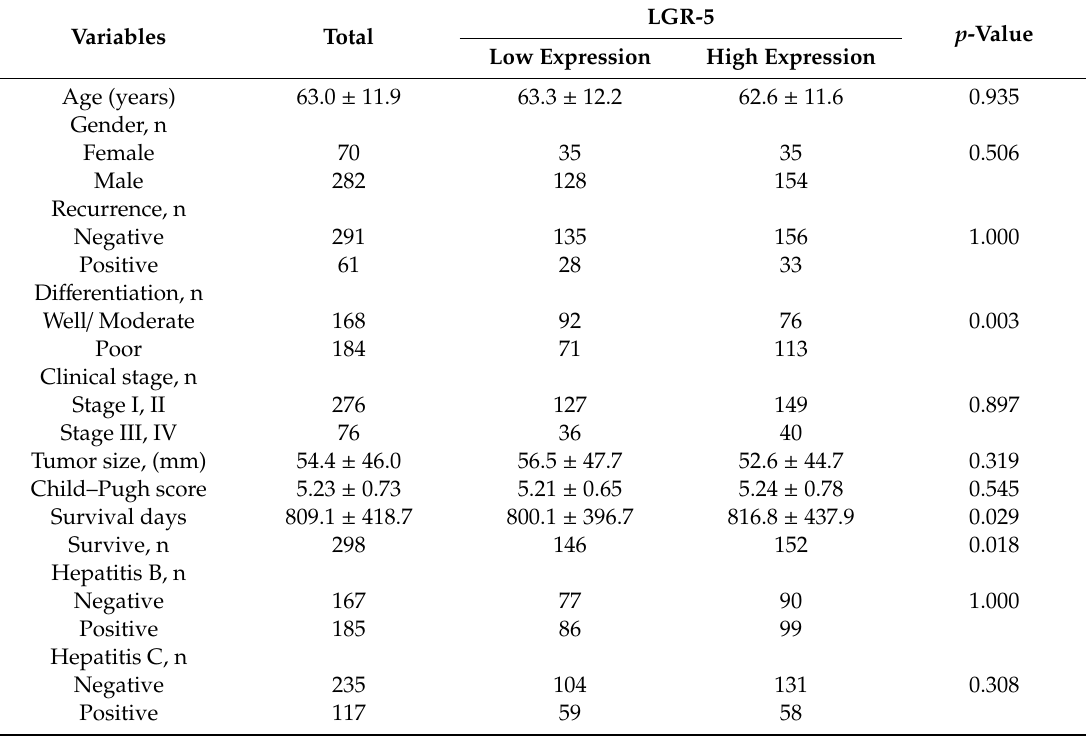
Table 1. Relationship of clinicopathological characteristics with LGR-5 expression in hepatocellular carcinoma (HCC)